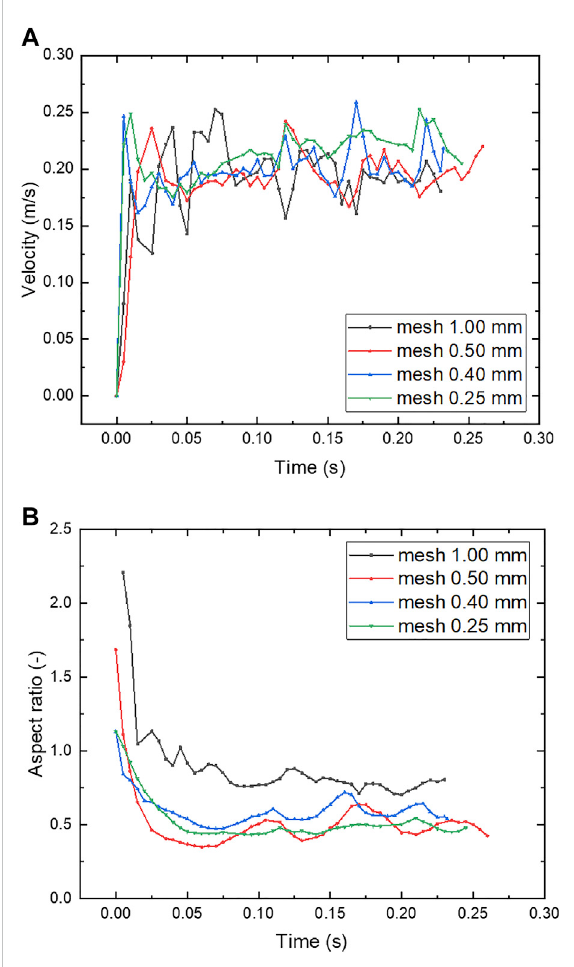
FIGURE 3 (A) Rising velocity and (B) aspect ratio of the bubble in water with different grid sizes, v g (cid:1) 1 m / s